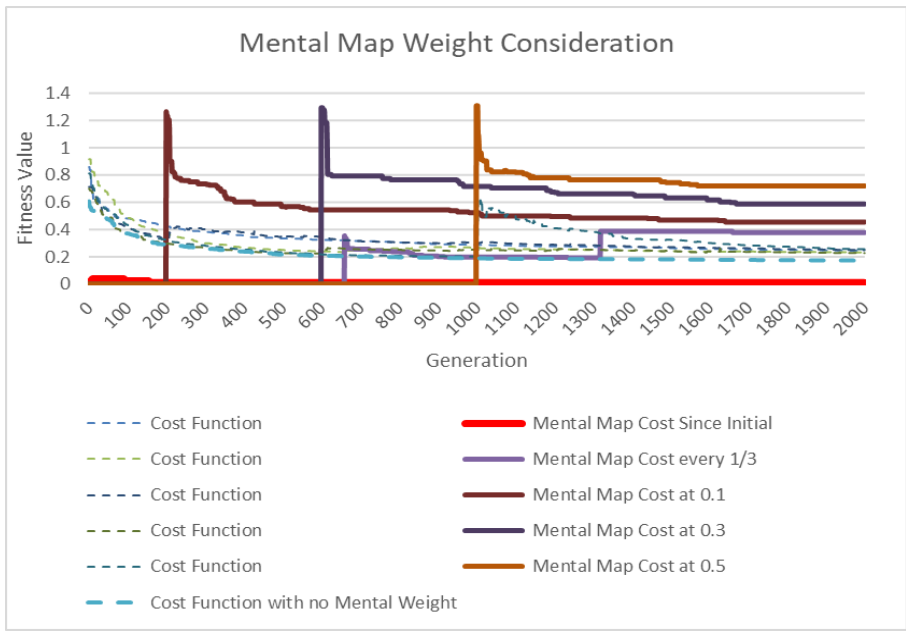
Figure 8. Mental map weight consideration difference.